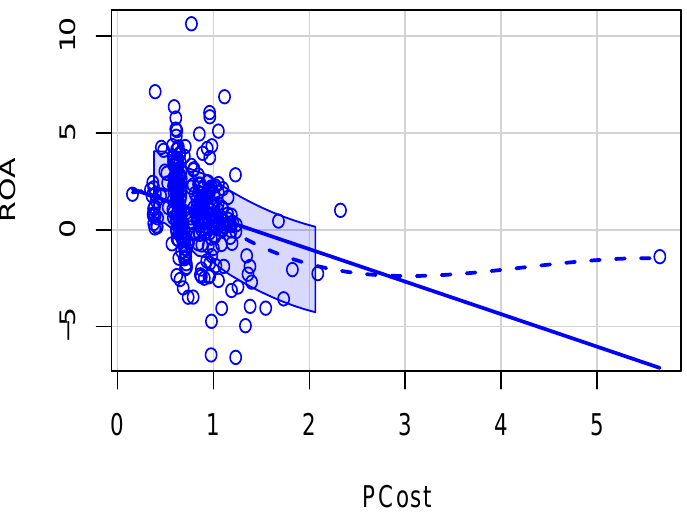
Figure 1. Cross-section example scatterplot of production cost and ROA illustrating presence of